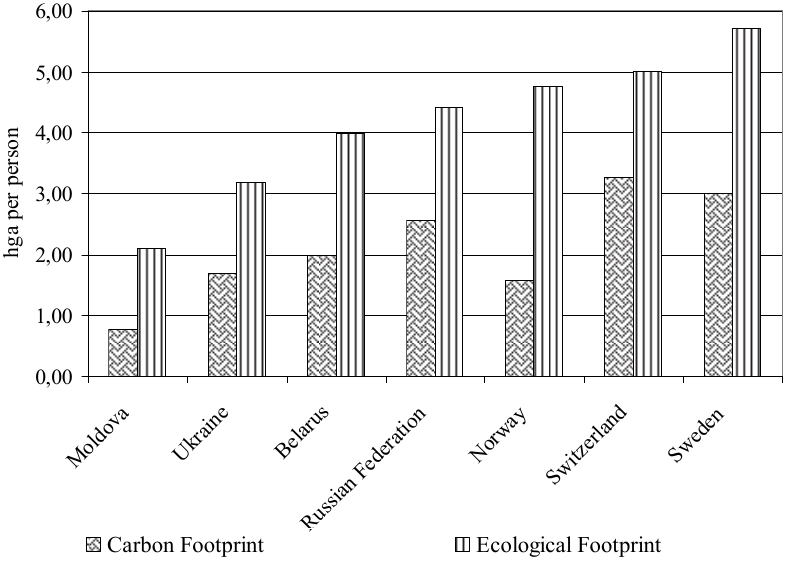
Fig. 1. Carbon component of ecological footprint (Eurostat,